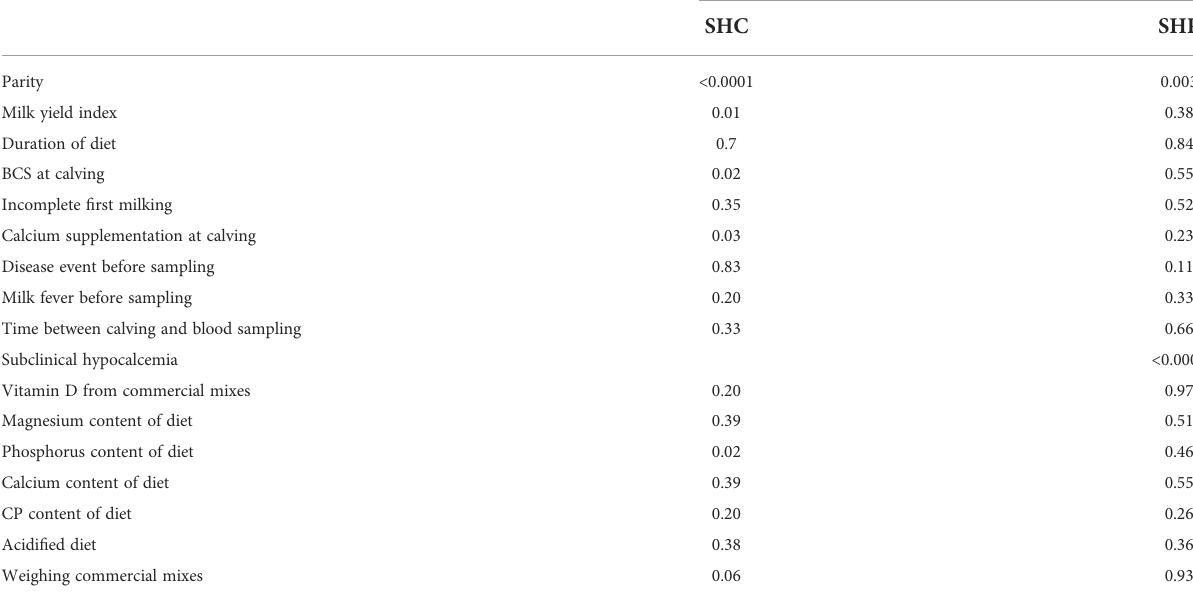
TABLE 5 Results from univariate tests quantifying the effects of parity, milk yield index and feeding practices during dry off on occurrence of subclinical hypocalcemia (SHC) or subclinical hypophosphatemia (SHP) (n = 371 cows).